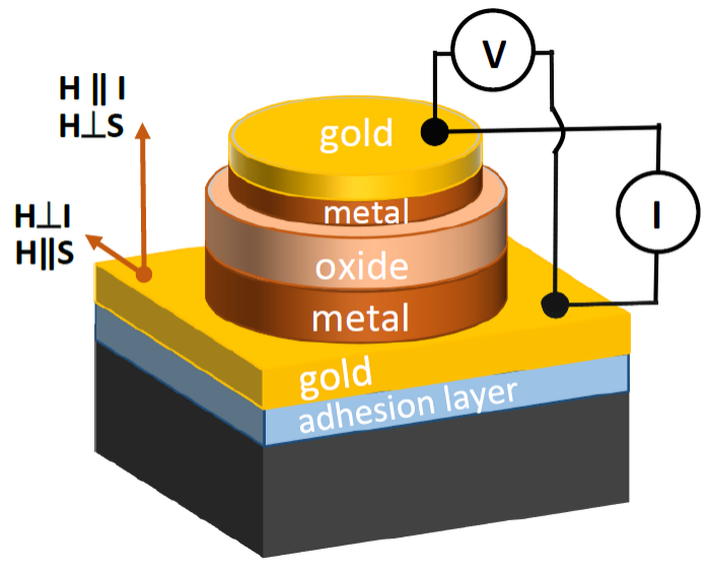
Figure 1. Schematic view of the metal/metal-oxide/metal